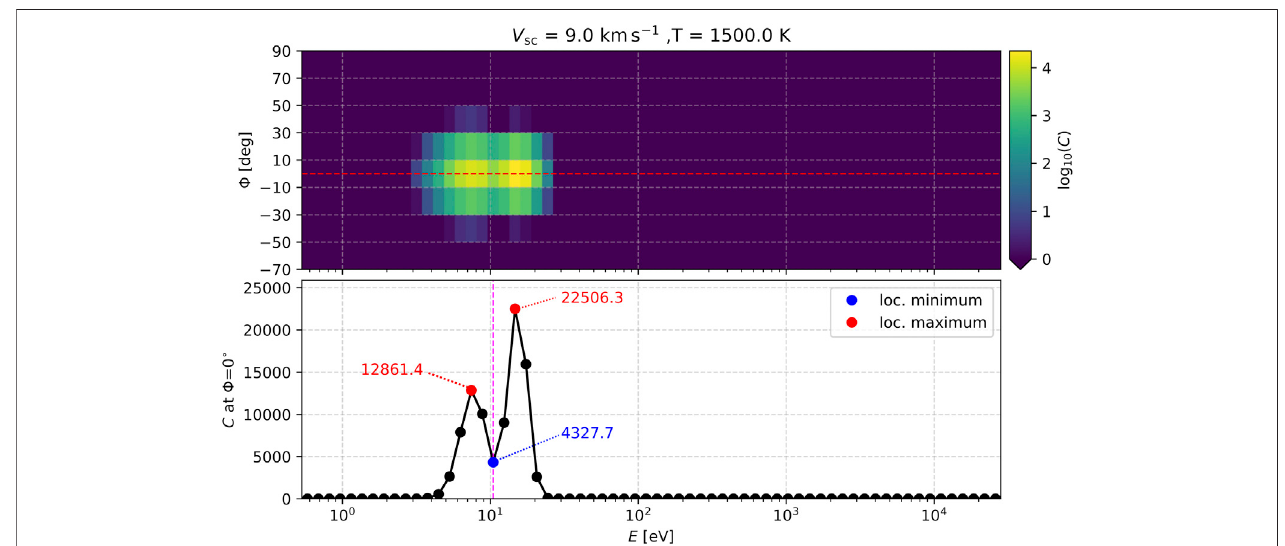
FIGURE 3 | (TOP) Logarithm of simulated counts as a function of energy E and azimuth angle Φ , expected to be measured by our concept instrument, assuming spacecraftspeed V sc =9 km/sandOH − andH 2 O-OH − plasmawith T =1500 K(0.13 eV).Wesetthesamedensityforbothspecies.Thespacecraftspeedisalongthe- x axis(see Figure1 ).Thereddashedlineindicatestheazimuthofthemaximumnumberofcountsrecorded.(BOTTOM)Countsvs.energyrecordedbytheazimuthsector with the maximum counts. The detected maxima and minima are shown with red and blue, respectively. The vertical magenta line indicates the energy of the local